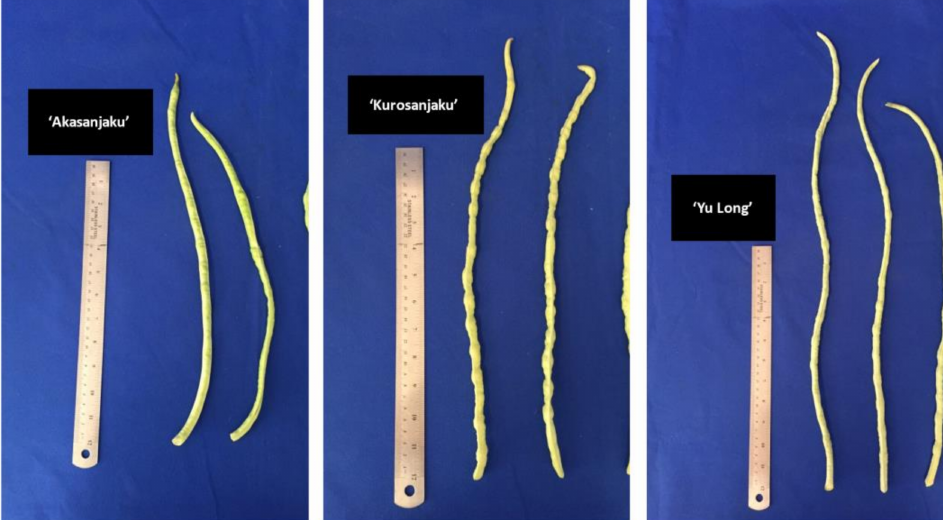
Figure 3. Representative photos of the three Yardlong bean cultivars (Akasanjaku, Kurosanjaku, and Yu Long) were harvested from field plots at 8 weeks after transplanting.